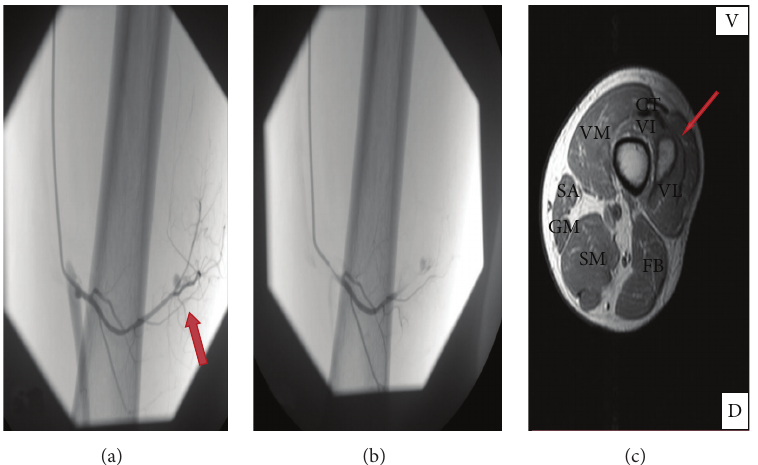
Figure 2: (a) A selective arteriography shows a point of active bleeding in a branch of the femoral artery at the level of the femoropopliteal junction (red arrow). (b) The image shows selective catheterisation of the bleeding branch (using Spongostan (cid:2) particles) to carry out the correct occlusion of the branch. (c) Nuclear magnetic resonance (axial thigh T1) is performed after a month to monitor the patient’s evolution. Subacute haematoma is observed in the distal third of the left thigh in the anterolateral compartment within the vastus intermedius muscle (VI). The haematoma did not present signs of spreading to other compartments or of affecting the adjacent femur. V: ventral. D: dorsal. VM: vastus medialis. VL: vastus lateralis. CT: quadriceps tendon. SA: sartorius. GM: gracilis muscle. FB: femoral biceps. SM: semimembranosus and semitendinosus muscle. Red arrow: subacute haematoma in